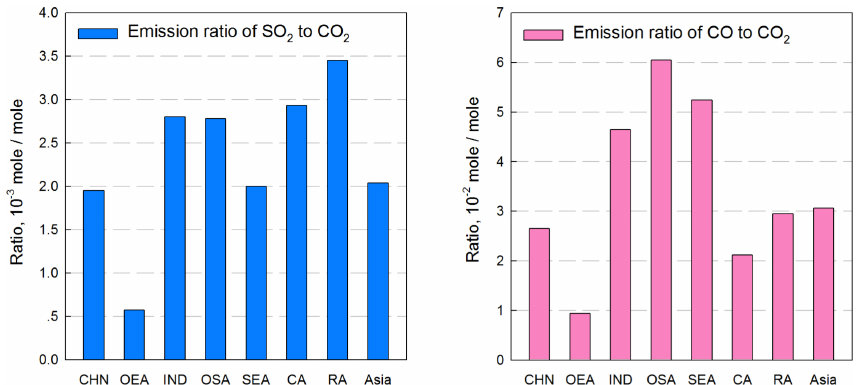
Figure 7. Emission ratios of SO 2 to CO 2 , and CO to CO 2 by Asian regions. CHN is China, OEA is Other East Asia, IND is India, OSA is Other South Asia, SEA is Southeast Asia, CA is Central Asia, and RA is Russia